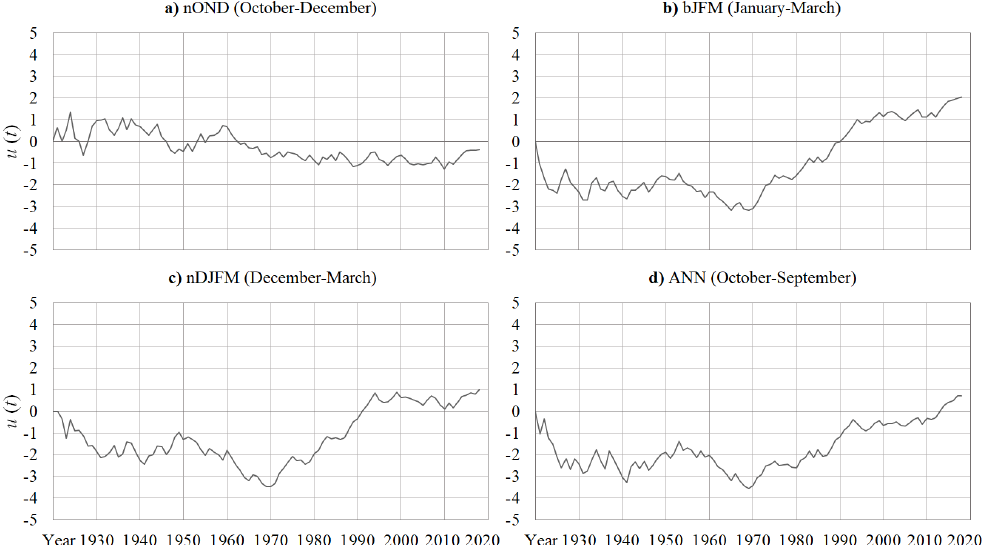
Figure 4. Progressive-trend series u ( t ) , unitless, of the quarterly nOND, nJFM; four-monthly nDJFM, and annual nANN NAO indices, NAOI; station-based indices based on the difference of SLP between Lisbon, Portugal and Reykjavik, Iceland—based on the data from Hurrell and NCAR [22]. As shown in Figure 2 (right side of each combo), all locations are experiencing rainfall downward trends regardless of the timescale (except for a tiny southern stripe in